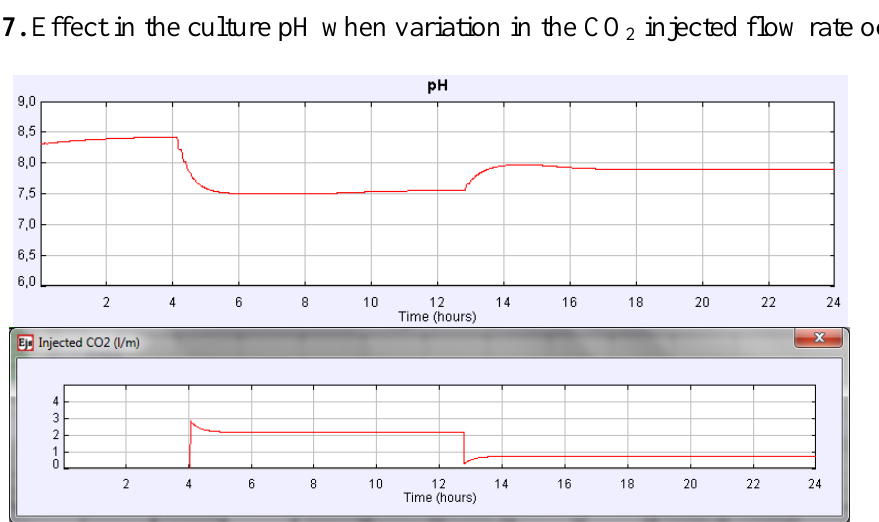
Figure 7. Effect in the culture pH when variation in the CO